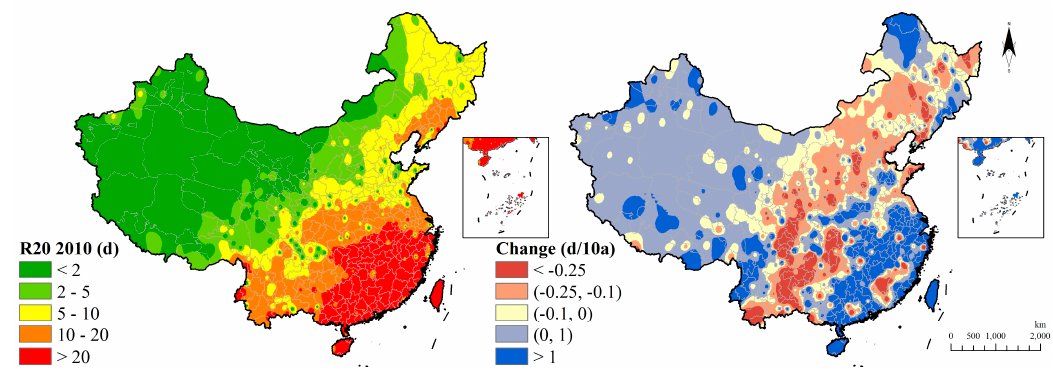
Figure 14. Heavy precipitation days indicator distribution and change.